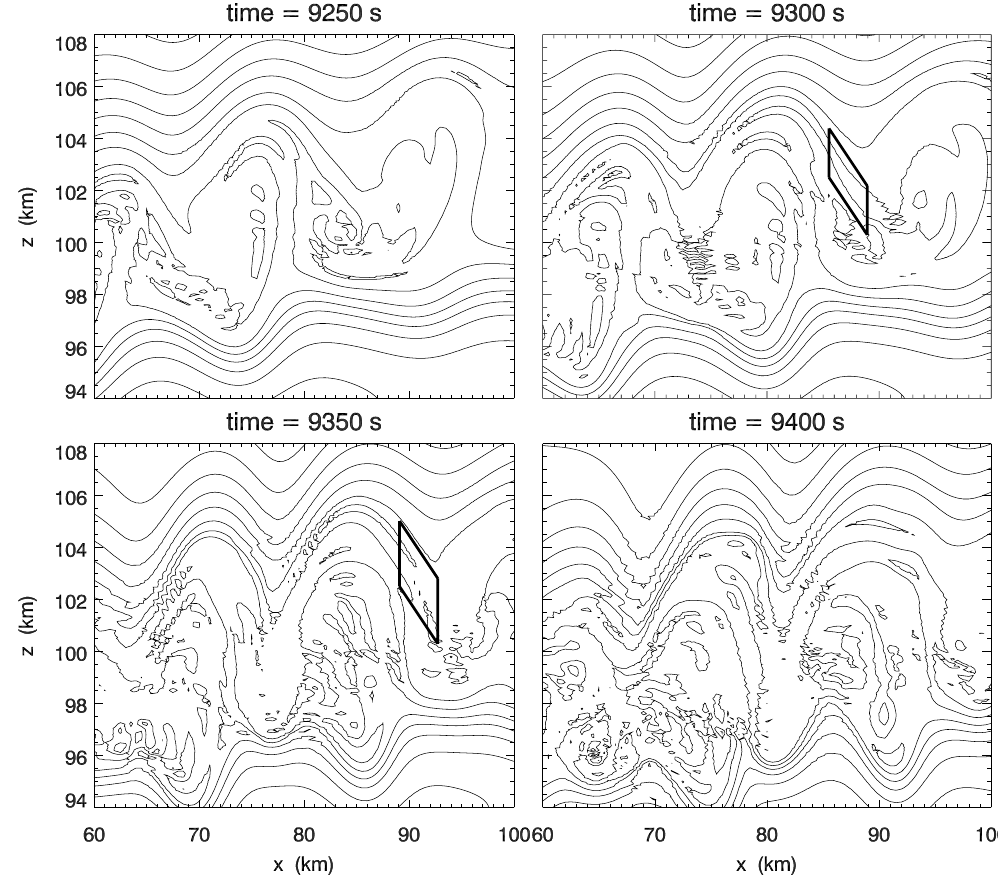
Fig. 3. Contour plots of the total potential temperature as the KH billows evolve.